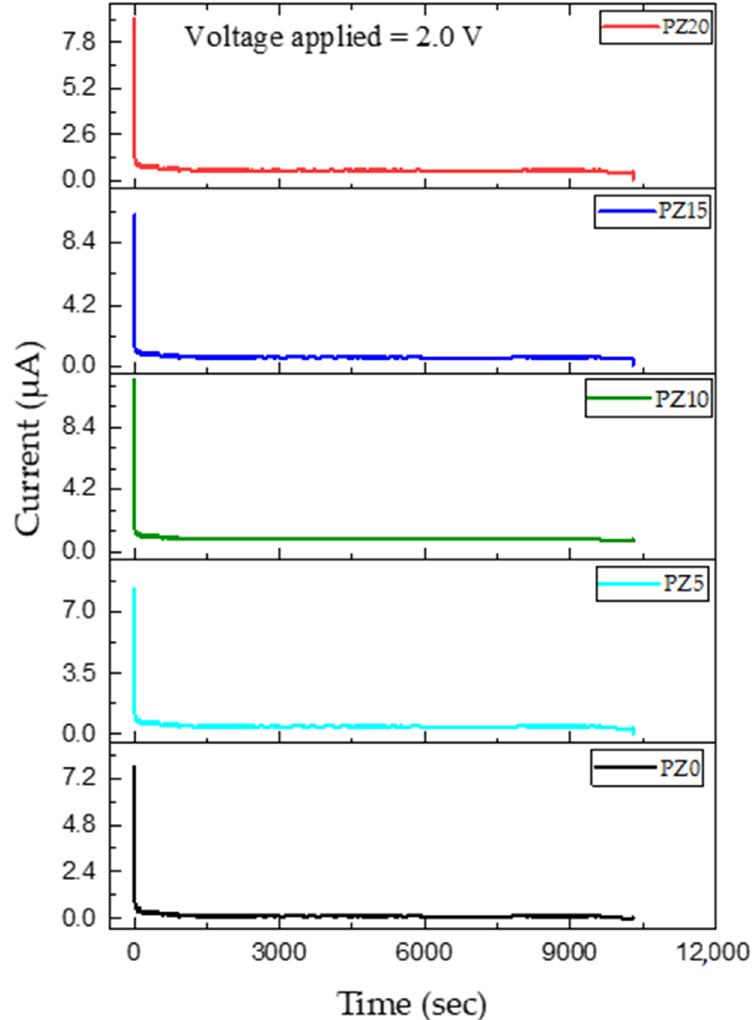
Figure 12. Polarization curve of ion transference number as a function of time of prepared SPEs.